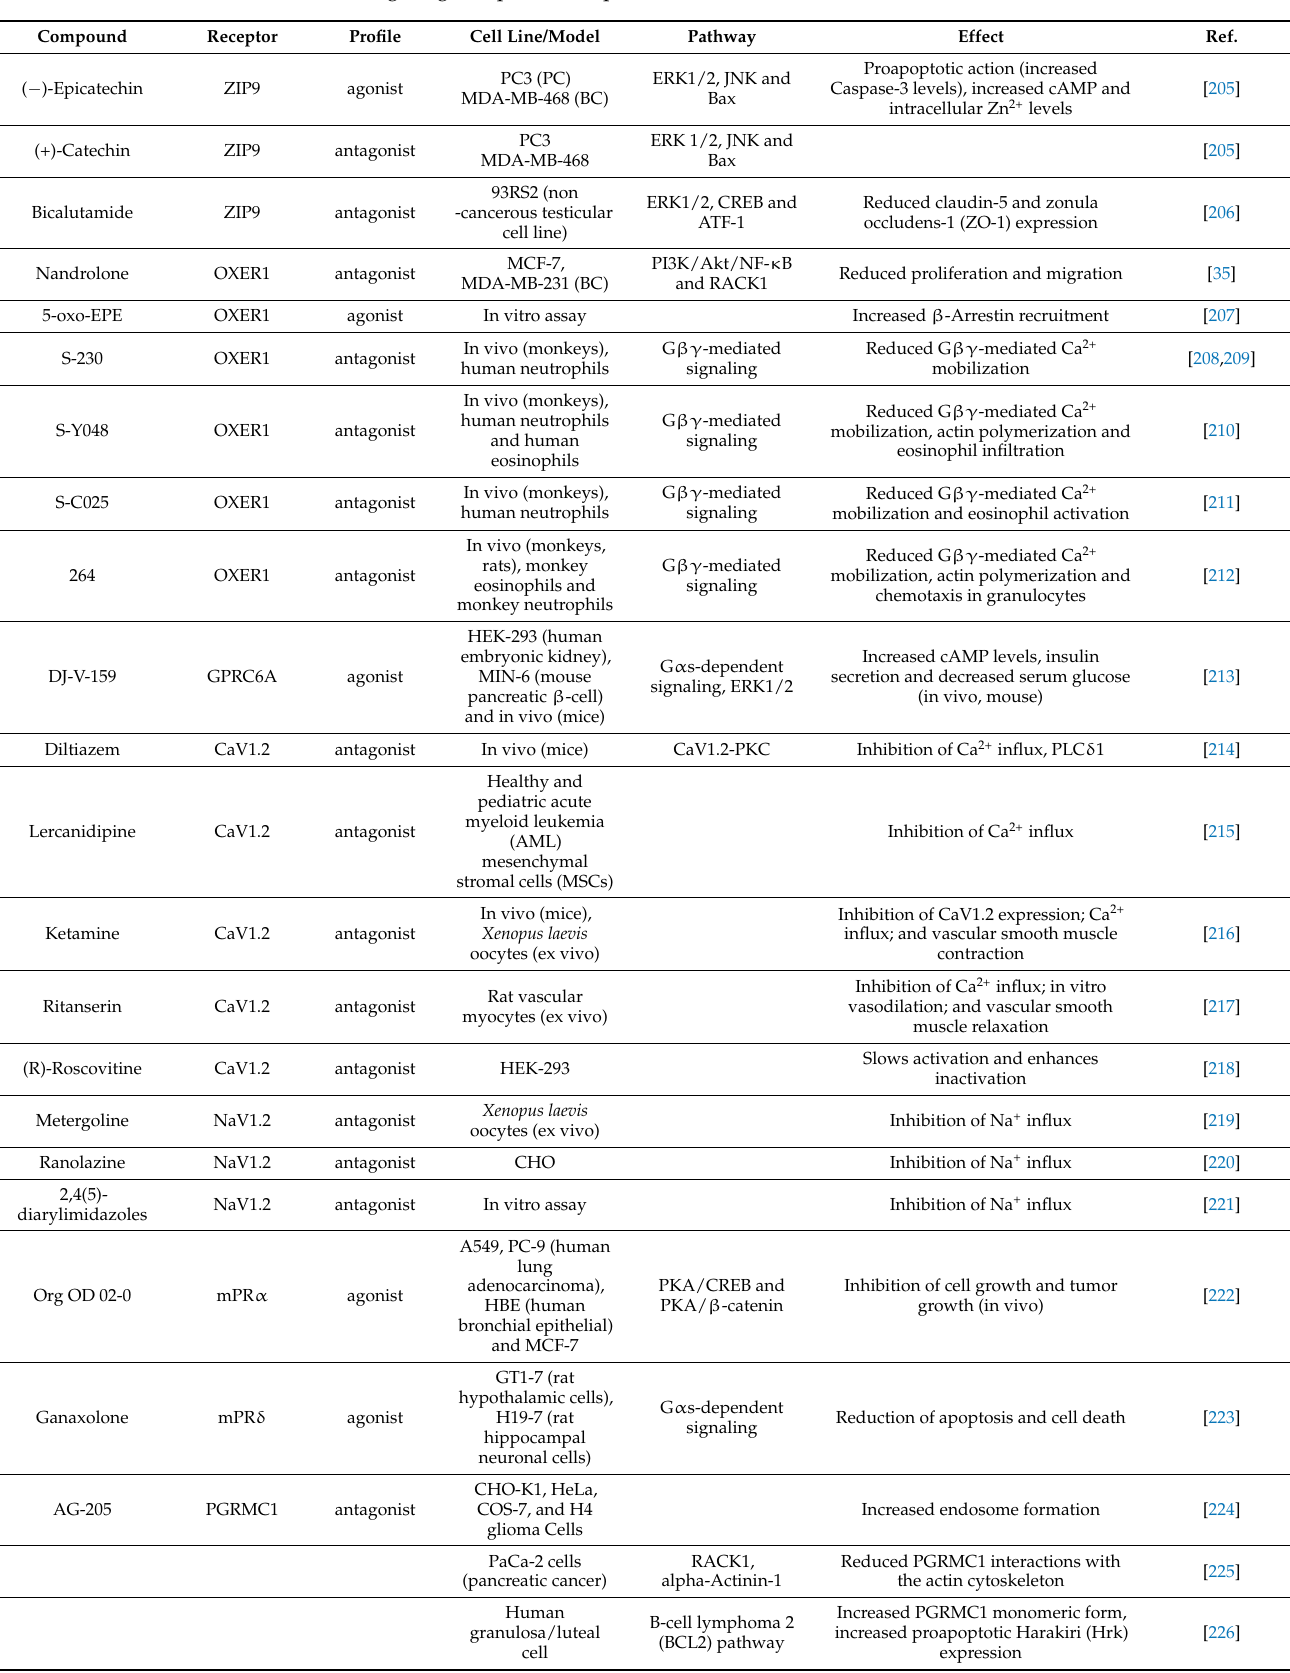
Table 1. mSR-targeting compounds in pre-clinical studies and their correlated